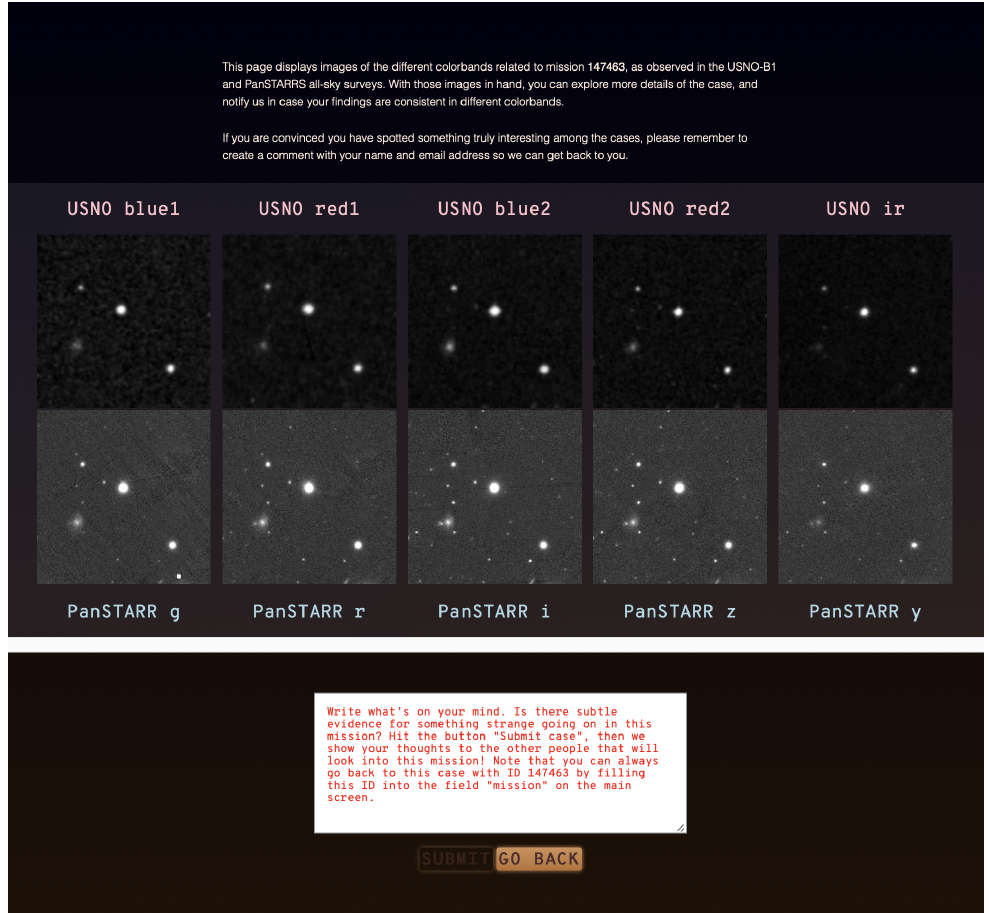
Figure 6. After pressing the “Inspect” button, 10 different images from the POSS surveys and Pan-STARRS are shown. The user is advised to do a careful comparison, take into account the different depth of the given images and asked to remark upon any unexpected findings in the commentary